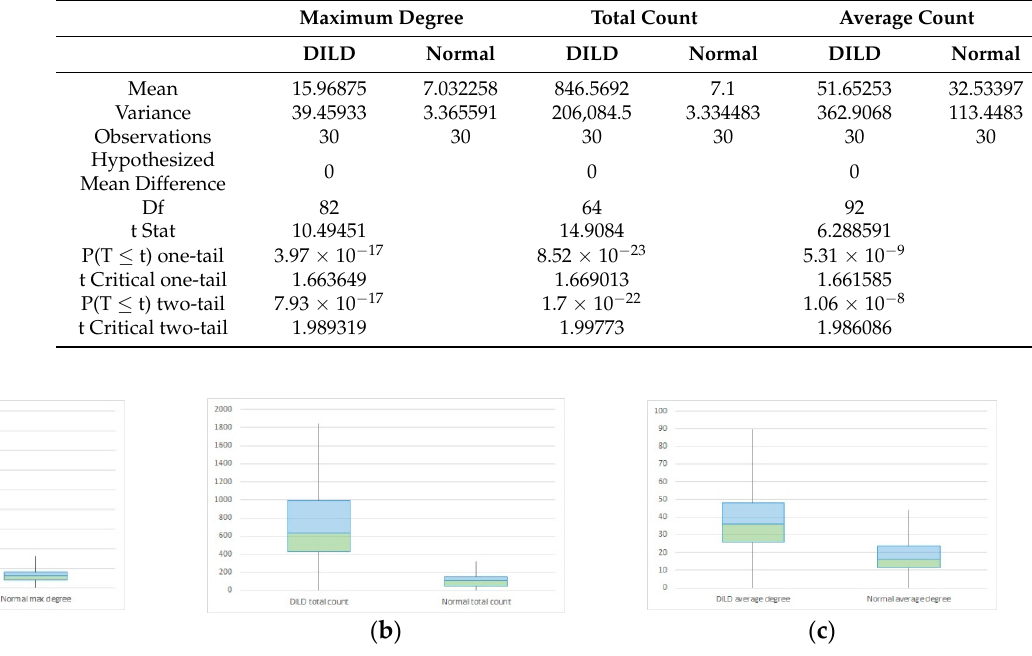
Figure 13. Box plot for DILD (left) vs. normal (right) for complex network parameters of ( a ) maximum degree ( b ) total count ( c ) average degree. Table 2. Statistical comparisons.